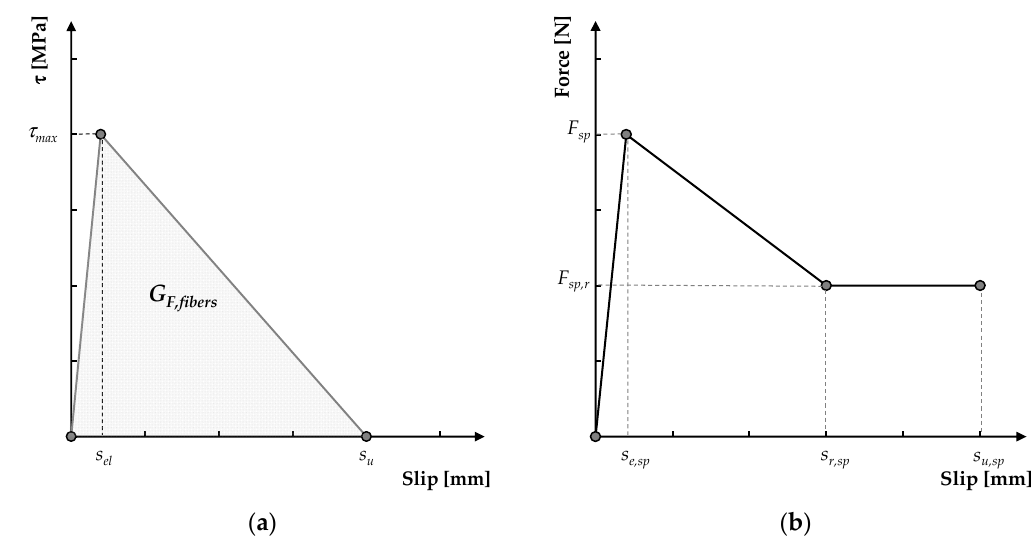
Figure 6. Bond-slip law for short fibers embedded within the cementitious matrix: ( a ) longitudinal tangential stresses during slipping and ( b ) simulation of the hooked end.